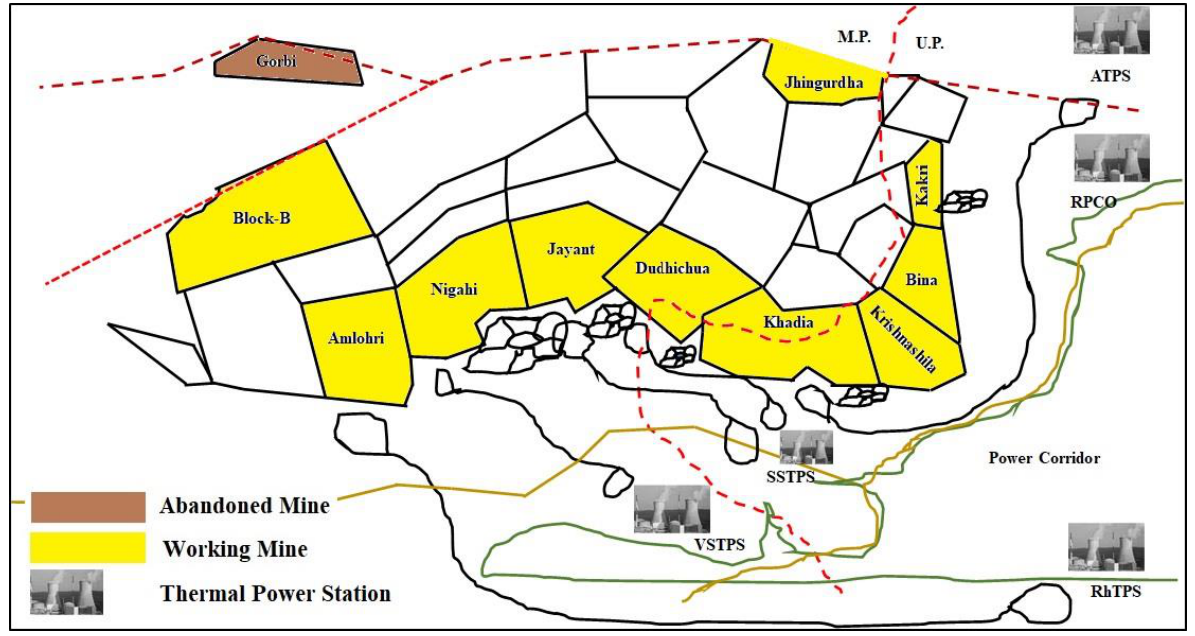
Figure 1. The study area.